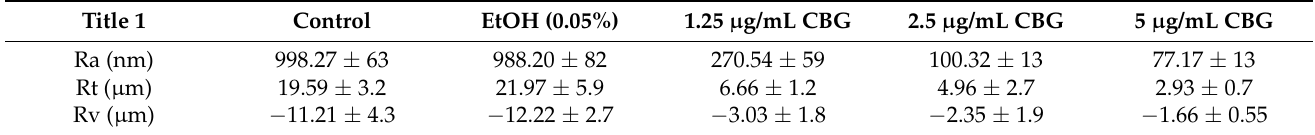
Figure 2. CBG reduces biofilm formation and prevents EPS production. HR-SEM images of untreated ( A , D ), CBG (5 µ g/mL)-treated ( B , E ) and EtOH (0.05%)-treated ( C , F ) S. mutans ( × 5000 + × 20,000 magnification). All treatments were applied for 24 h. The images are representative of three independent experiments. Table 2. Table of roughness profile: roughness parameter (Ra), the maximum height (Rt), and maximum valley depth (Rv). The results are representative of three experiments. N = 3. p <